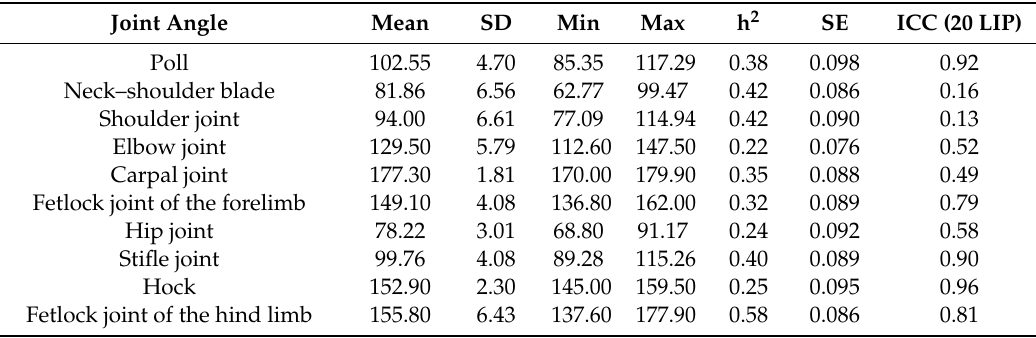
Table 1. Mean, standard deviation (SD), minimum, maximum, genome-wide heritability, and standard error (SE) for 495 horses, and the reproducibility (ICC) of the joint angle measurements of 20 Lipizzan horses